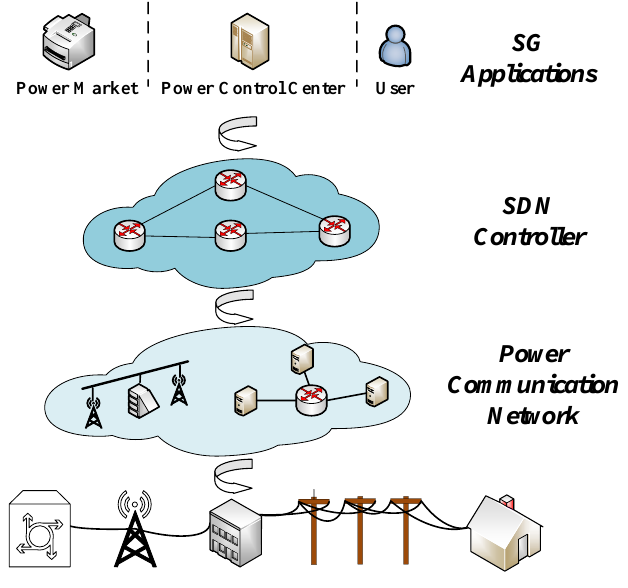
Figure 2. Application of SDN in SG. By applying programmable SDN Controllers, the communication resource in SG will be dynamically